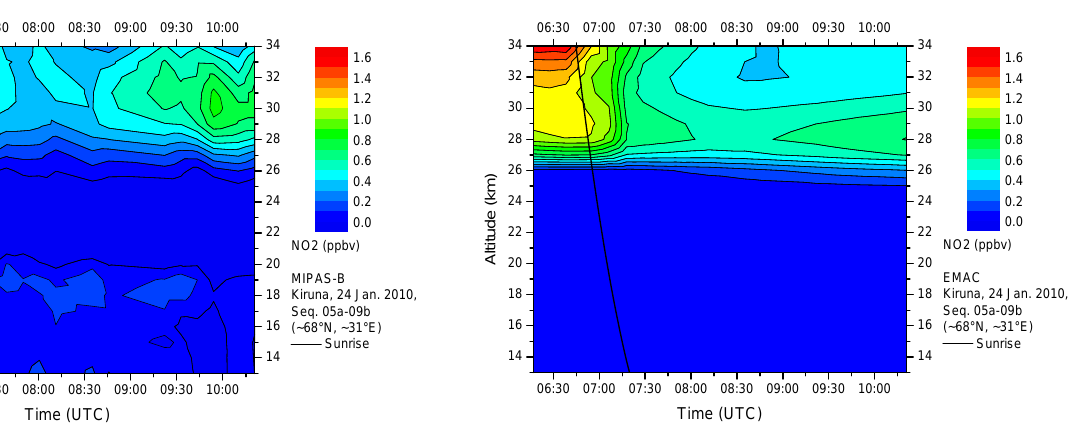
Fig. 10. NO 2 mixing ratios retrieved from MIPAS-B spectra recorded around sunrise on 24 January 2010. The strong photochemically induced decrease of NO 2 mixing ratios starts about 20 minutes after sunrise followed by a slower increase of NO 2 amounts due to N 2 O 5 photolysis. For details, see text.